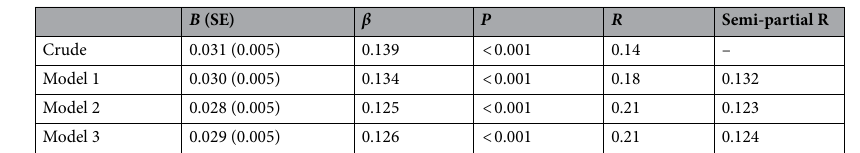
Table 3. Multiple regression analyses results of health literacy and life satisfaction. SE, standard error; B, unstandardized regression coefficients; β , standardized regression coefficients, R : coefficient of multiple regression, semi-partial R : semi-partial coefficient of health literacy in the multiple regression models. Model 1 adjusted for age, sex, income, education, and marital status; Model 2, psychological stress; Model 3, status of diabetes mellitus, hypertension, dyslipidemia, cancer, and obesity,